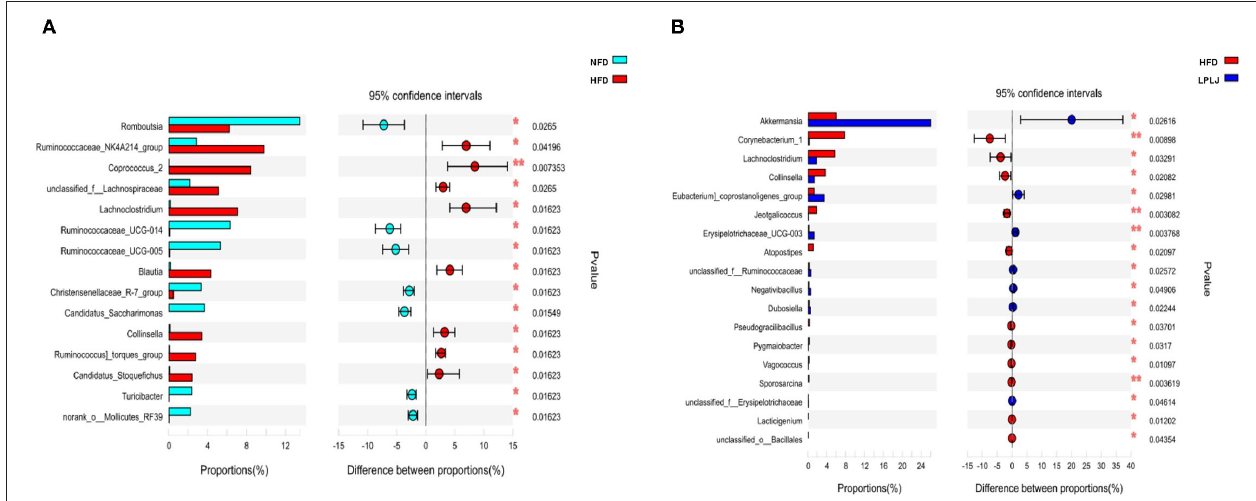
FIGURE 5 | Extended error bar plot comparing the differences in the mean proportions of the significantly altered intestinal microbial phylotypes. The differences between groups were determined using a Welsh’s t -test, and the Benjamini-Hochberg procedure was used to control the false-discovery rate due to multiple testing. Corrected P values are shown at right. (A) NFD group vs. HFD group, (B) HFD + LPLJ group vs. HFD group. Values were expressed as mean ± SEM in each group ( n = 8). * p < 0.05, ** p < 0.01.